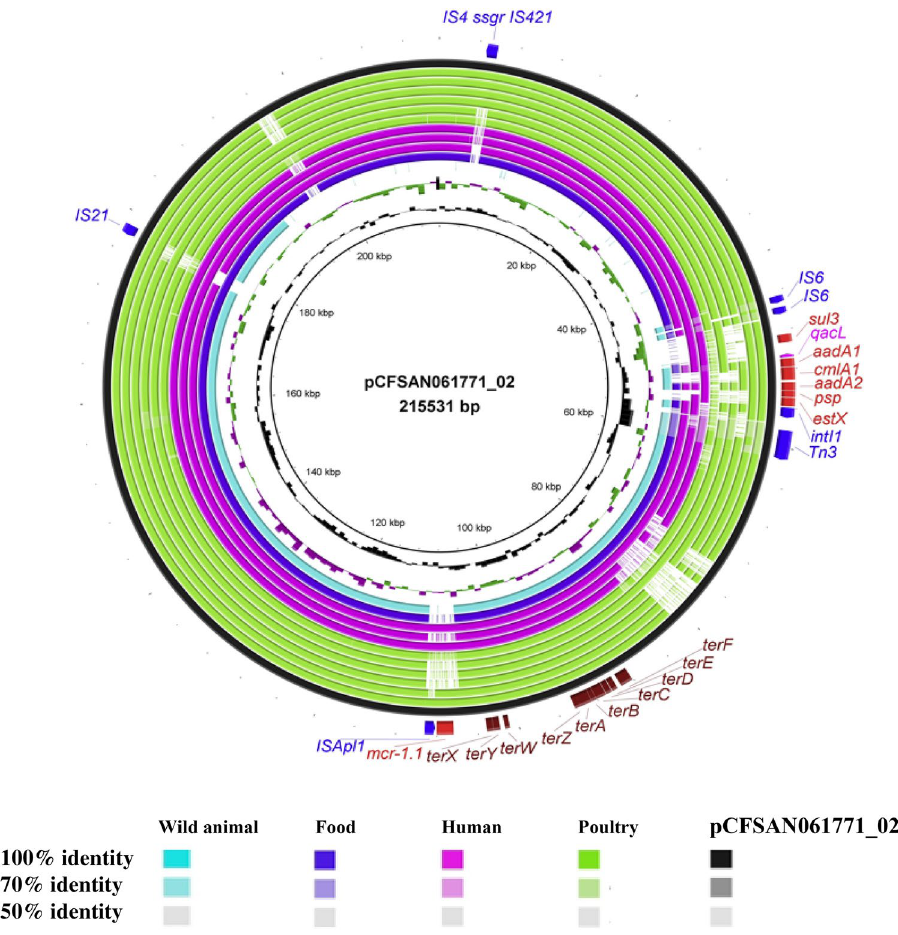
Figure 4. BRIG comparison of pCFSAN061771_02–like plasmids in Escherichia coli ST1485 strains. The pCFSAN061771_02 plasmid from the CFSAN061771 strain was used as reference for alignment and gene annotation as is shown in the outermost black circle. Query genomes are color-coded according to source and the order plotted in the circle reflects their similarities to pCFSAN061771_02. Gene inventories are colored as follow: red (antibiotic resistance genes; blue (mobile elements); fuchsia (quaternary ammonium compound); and maroon ( tar locus). Strains are arranged from inside as follow; animal strain LD67-1 (pLD67-1-157